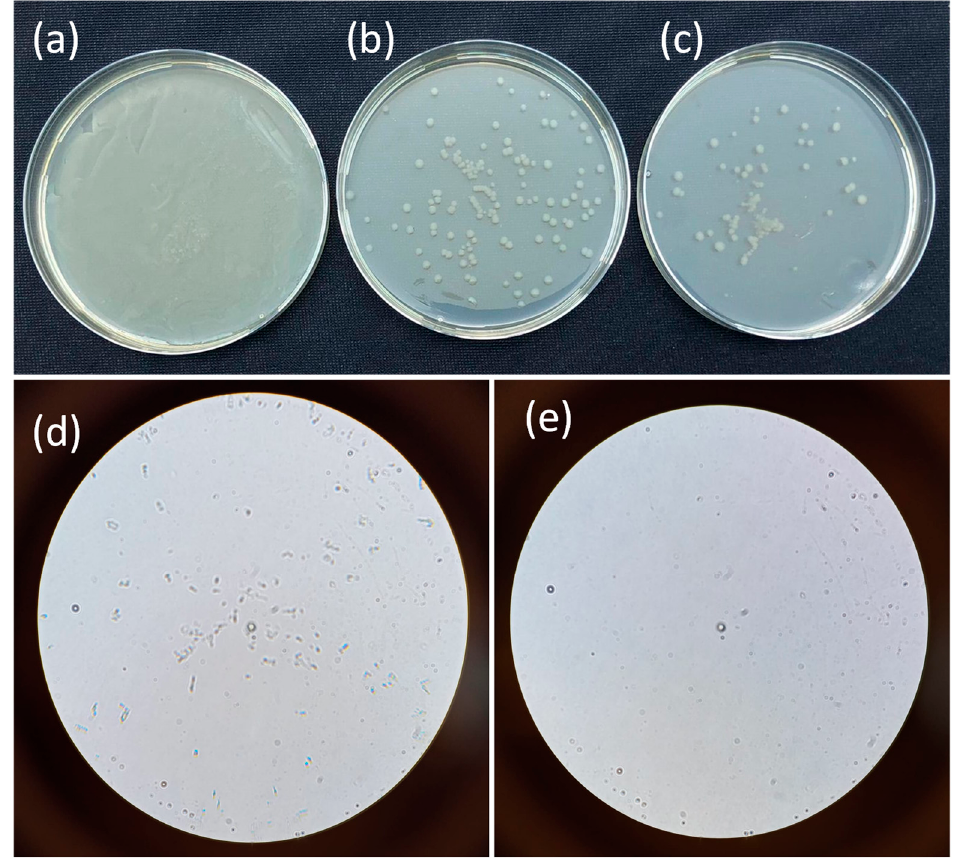
Figure 6. Plate samples of formed E. coli cells ( a ) without the addition of LDH ( b ) E. coli + DMAC + 250 mg/L LDH, and ( c ) E. coli + DMAC + 500 mg/L LDH, E. coli colonies grown on TFC ( d ) and TFN 3 membranes ( e ).